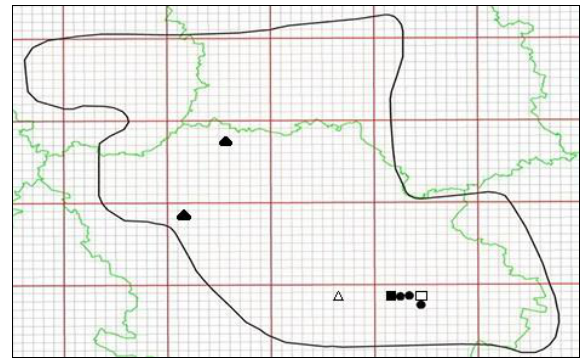
Fig. 5. The distribution of selected ephemerophytes in the Romensko-Poltavsky Geobotanical District: A. Astrodaucus orientalis (L.) Drude;